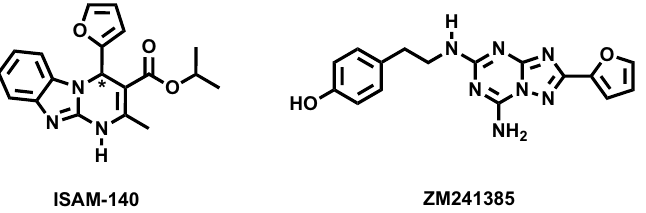
Figure 1. 2D representation of the chemical structures of the AR ligands used in this work, i.e. ZM241385, ( ±) ISAM-140, (R)-ISAM-140 and (S)-ISAM-140. The chiral center in ISAM-140 is indicated with an